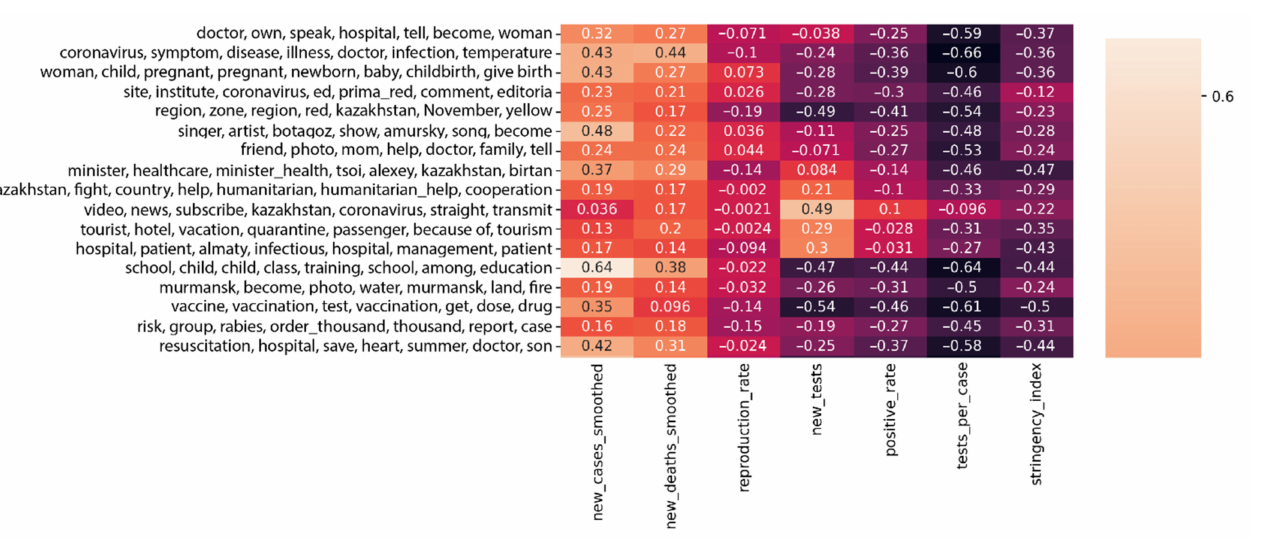
Figure 3. Correlation between thematic clusters expressed as sets of the most relevant words (vertical) and pandemic indicators (bottom horizontal: variables new_cases_smoothed, new_deaths_smoothed,